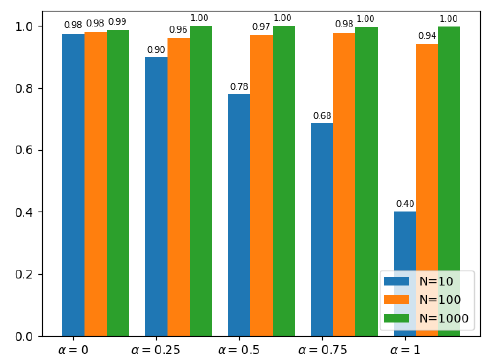
Figure 3. Comparison of fidelity when σ = 1, α is divided into quarters in the interval 0 to 1.